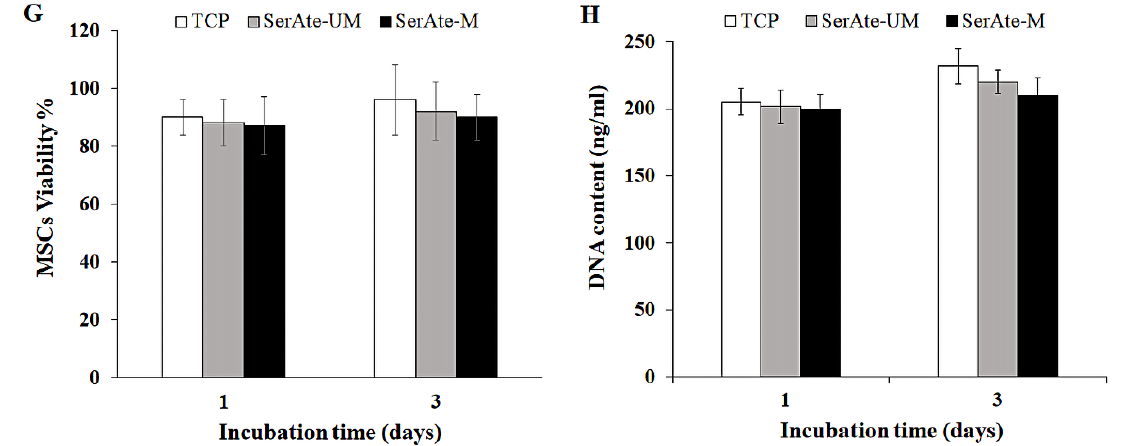
Figure 7. DAPI (blue) and phalloidin (red) stained images of hMSCs seeded on TCP ( A ), SerAte-UM ( B ), and SerAte-M ( C ) hydrogels after three days of incubation in basal medium. Live (green) and dead (red) stained images of hMSCs seeded on TCP ( D ) or encapsulated in 15% wt SerAte-UM ( E ) and SerAte-M ( F ) hydrogels with 31% degree of modification after three days of incubation. The scale bar in ( A – F ) is 100 µ m. Percent viability ( G ) and dsDNA content ( H ) of hMSCs seeded on TCP and encapsulated in 15 wt% SerAte-UM and SerAte-M hydrogels with 31% degree of modification as a function of incubation time. Error bars correspond to mean ± SD for n =